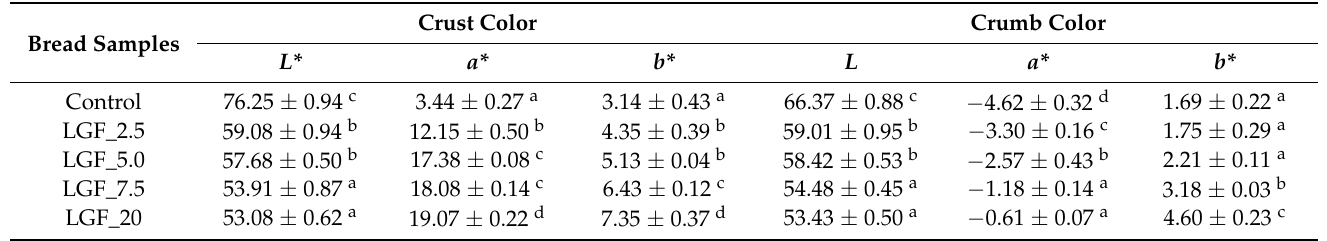
Table 3. Color parameters of the bread samples with different levels of LGF addition in wheat